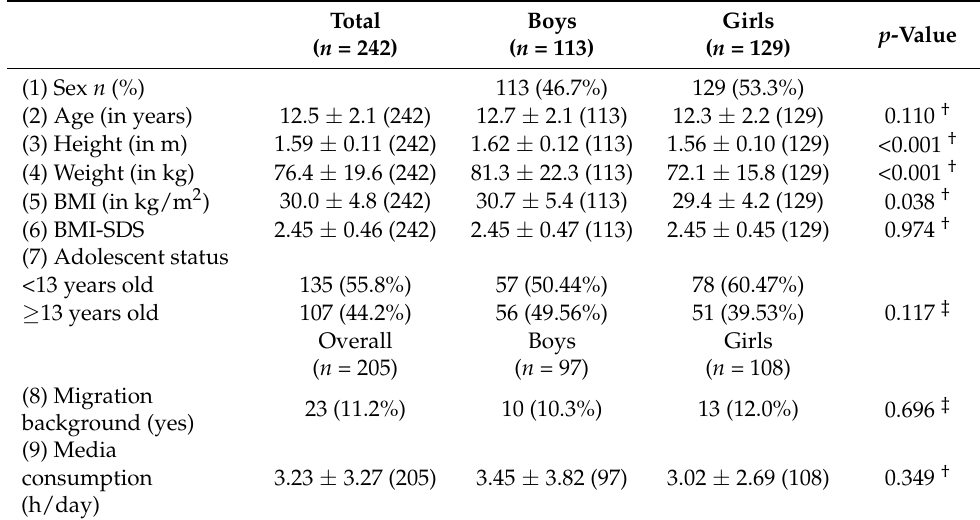
Table 1. Population